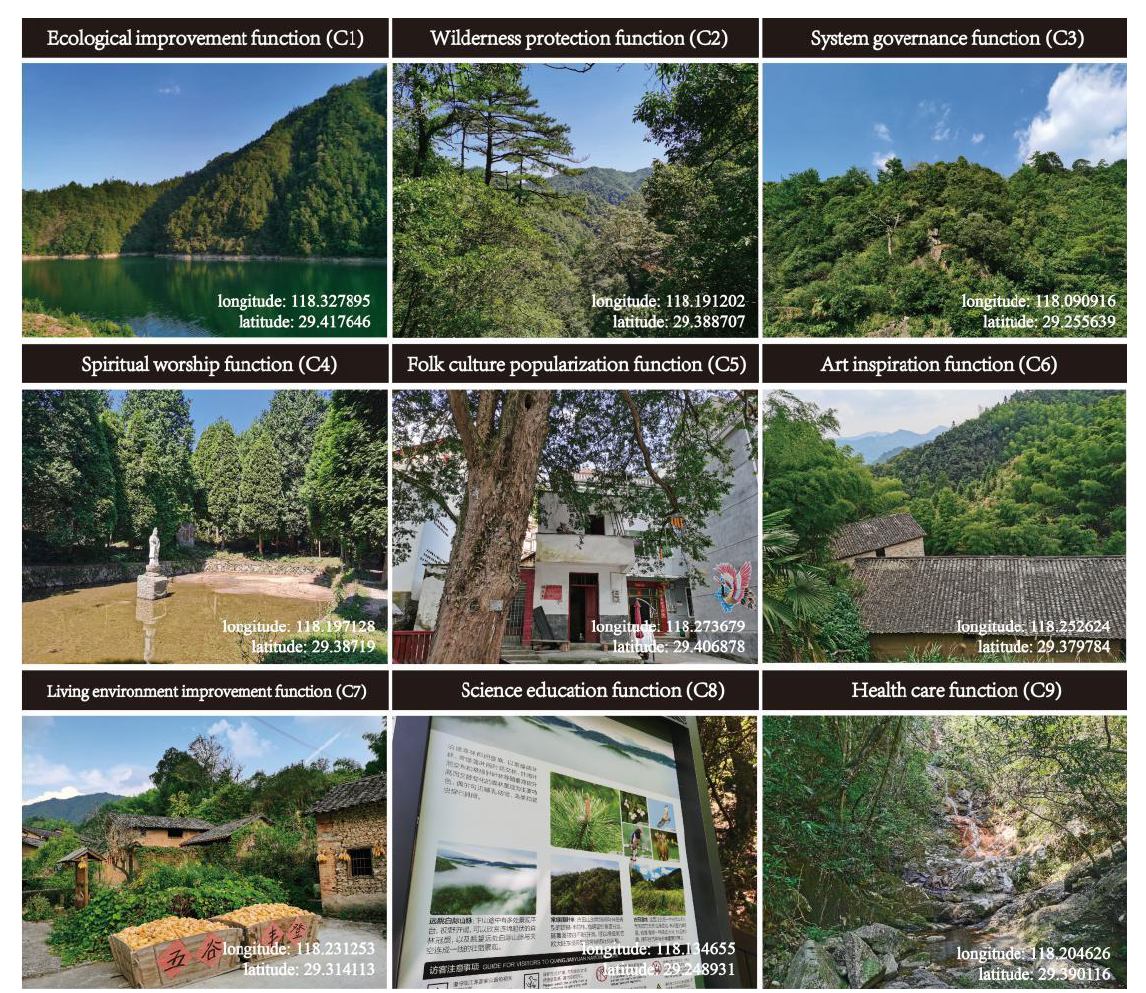
Figure A1. Schematic representation of representative landscapes for cultural ecosystem services.